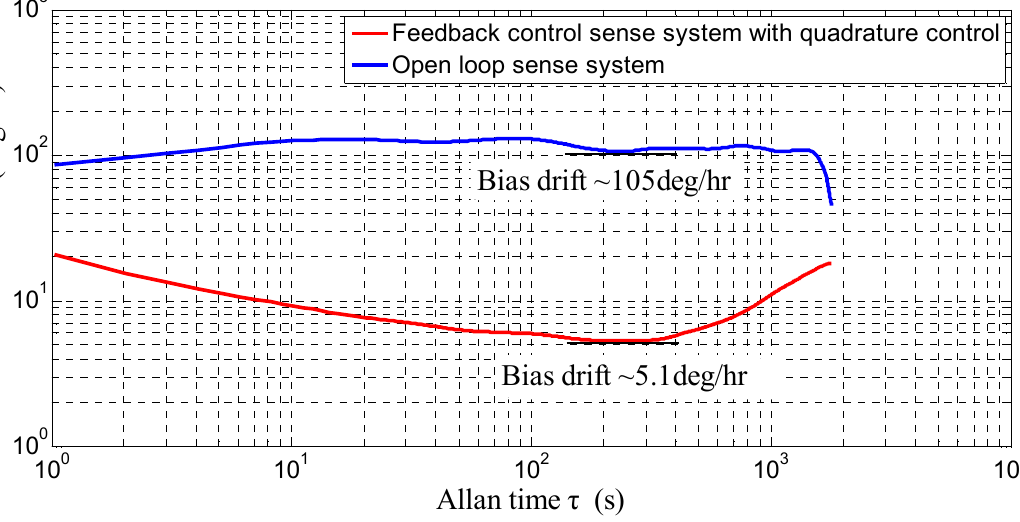
Figure 17. Bias drift in open loop sense system and feedback control sense system with quadrature control loop.